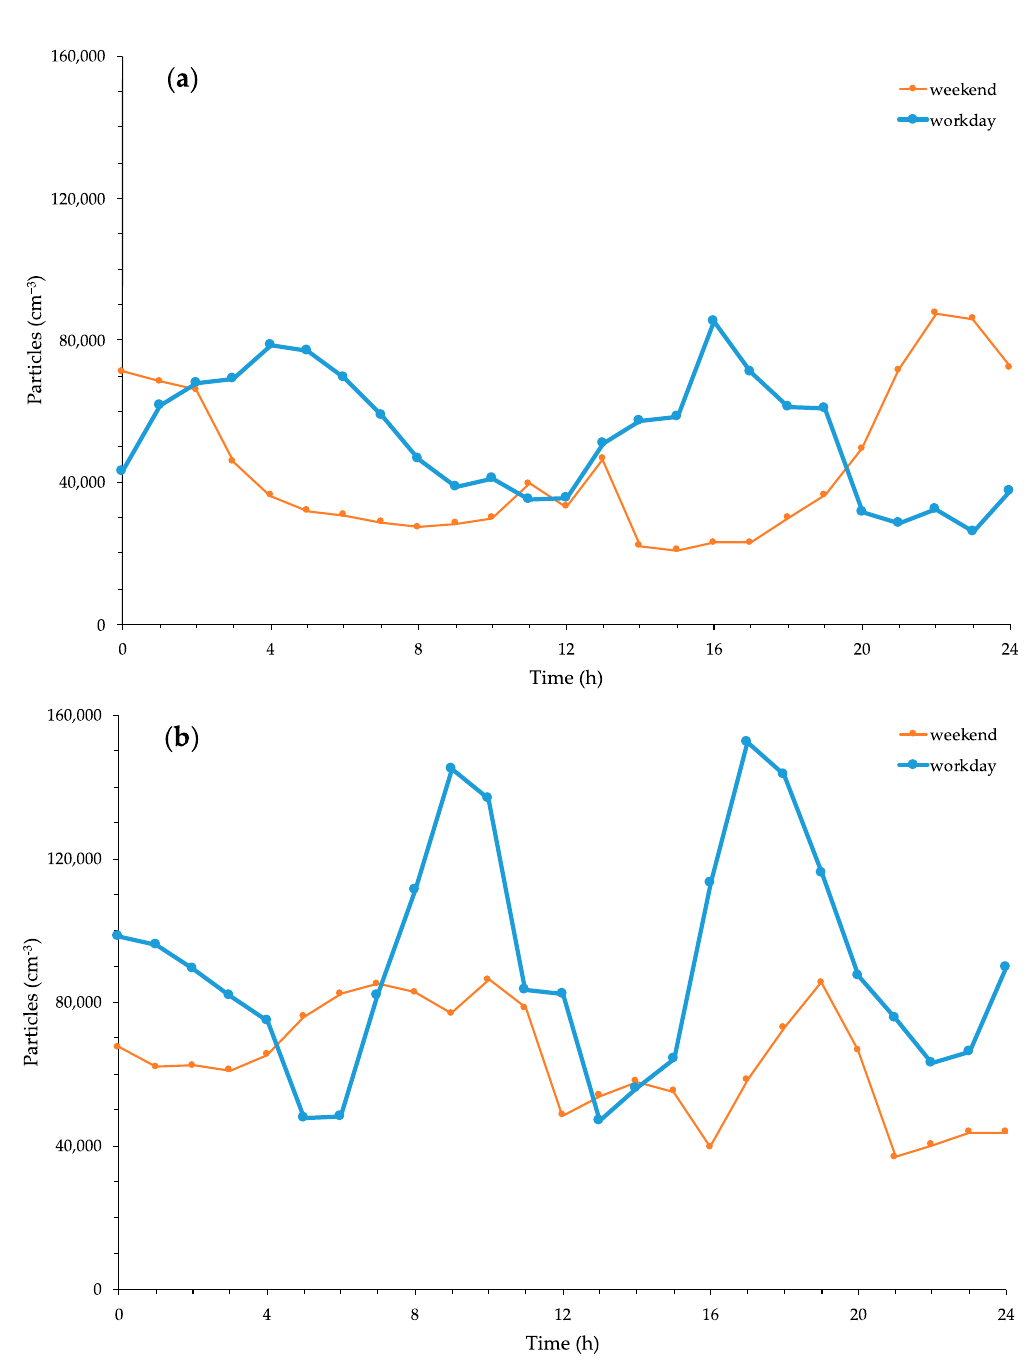
Figure 3. Typical daily behavior of the particle number concentrations during the workday and weekend in ( a ) October and ( b ) December in downtown Rome. weekend in ( a ) October and ( b ) December in downtown